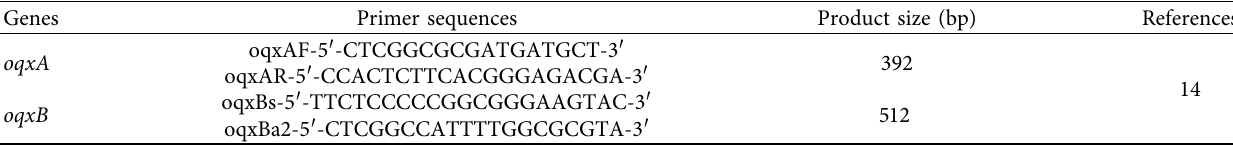
Table 1: Primers used in this study.